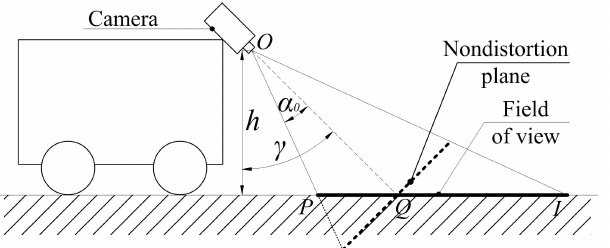
Figure 1. The field of view of an onboard camera.